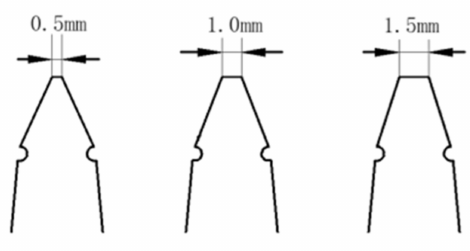
Figure 19. Local cavitation nose